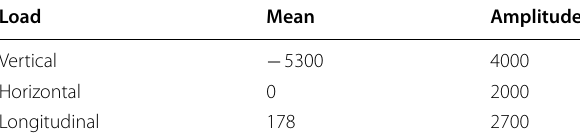
Table 1 Fatigue test loads on the cast aluminum beam (N)